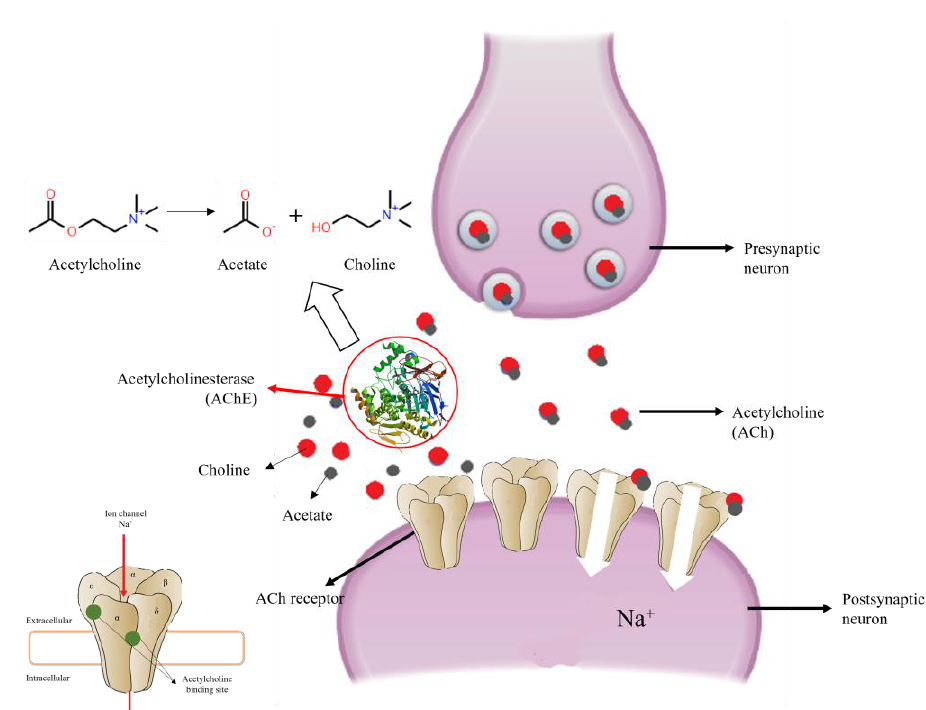
Figure 4. Normal functioning of the enzyme Acetylcholinesterase (AChE) in the transmission of nerve impulses. Modified from Jankowska et al. [113] and Basicmedical Key [114].